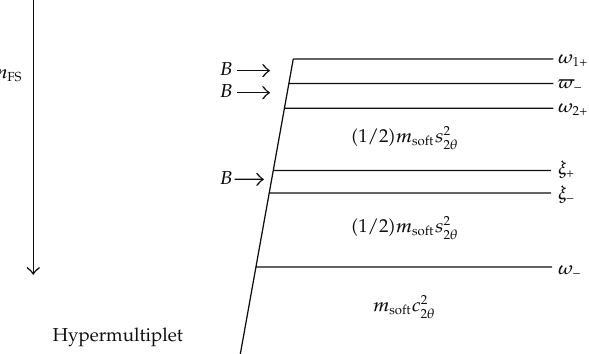
(cid:3) m (cid:13) m (cid:4) , e p